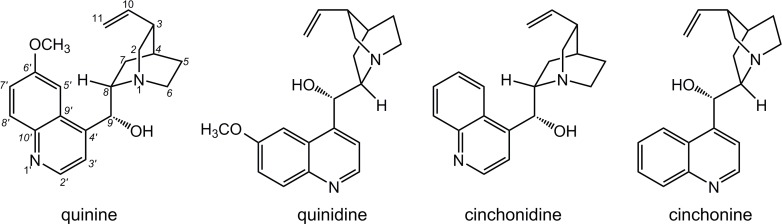
Cinchona alkaloids.